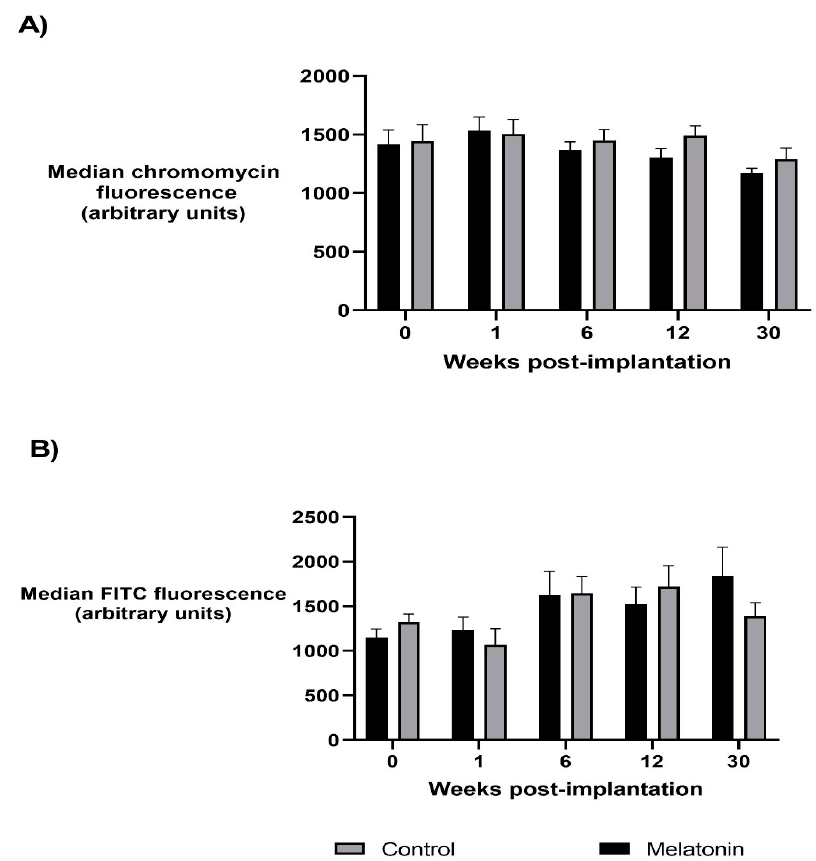
Figure 1. The relative levels of sperm protamine deficiency ( A ) and global methylation of the sperm epigenome ( B ) in ejaculates collected from melatonin-treated and control rams over the study period. Changes in protamine deficiency ( A ) and global methylation ( B ) are represented by the median chromomycin and FITC fluorescence of the sperm population, respectively. Values are the mean ± SEM; no significant difference is reported between treatment groups or study weeks ( p > 0.05).